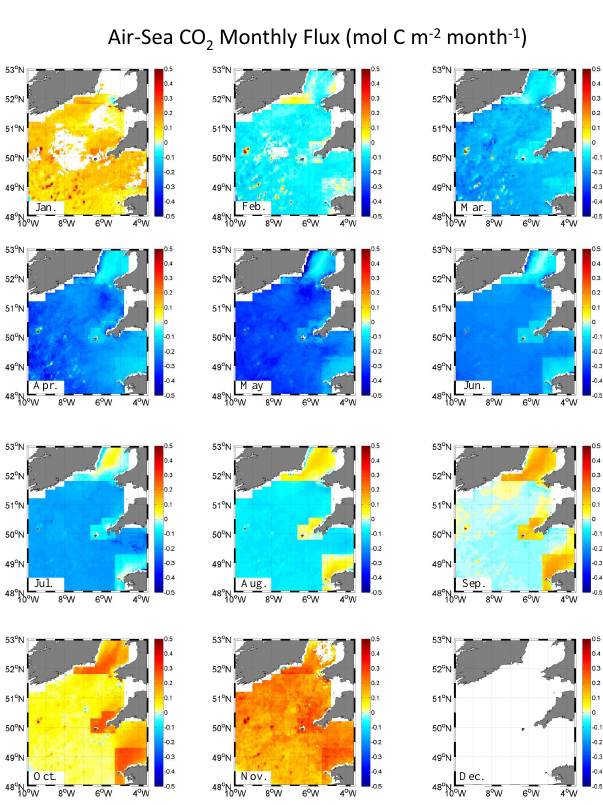
Figure 11. Monthly air–sea CO 2 fluxes (molCm − 2 month − 1 ) computed from p CO 2,MLR and using Nightingale et al. (2000) K – wind relationship, averaged from 2003 to 2013 from January (top left corner) to December (bottom right corner). Negative values in- dicate CO 2 sink.